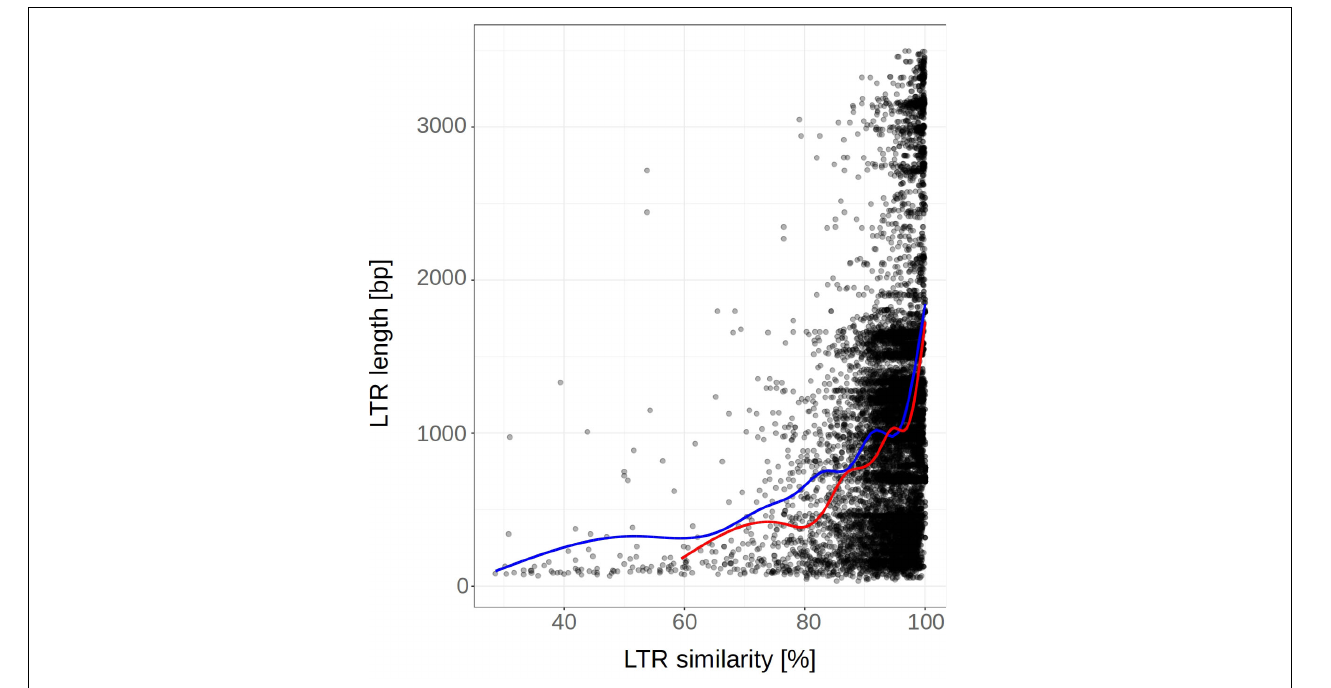
FIGURE 7 | LTR length plotted against the 5 (cid:48) -3 (cid:48) LTR similarity before and after removal of gene converted regions (predicted by GENECONV). LTR retrotransposon of fifteen plant species ( n = 5812). Smooth curves (fitted using “loess” method) are plotted for LTRs before and after GCE removal (red and blue color, respectively). Nested, original and non-nested LTR retrotransposons were analyzed together. The removal of converted regions from the LTRs has shifted the curve to the left resulting in an increase of LTR retrotransposon age estimates.